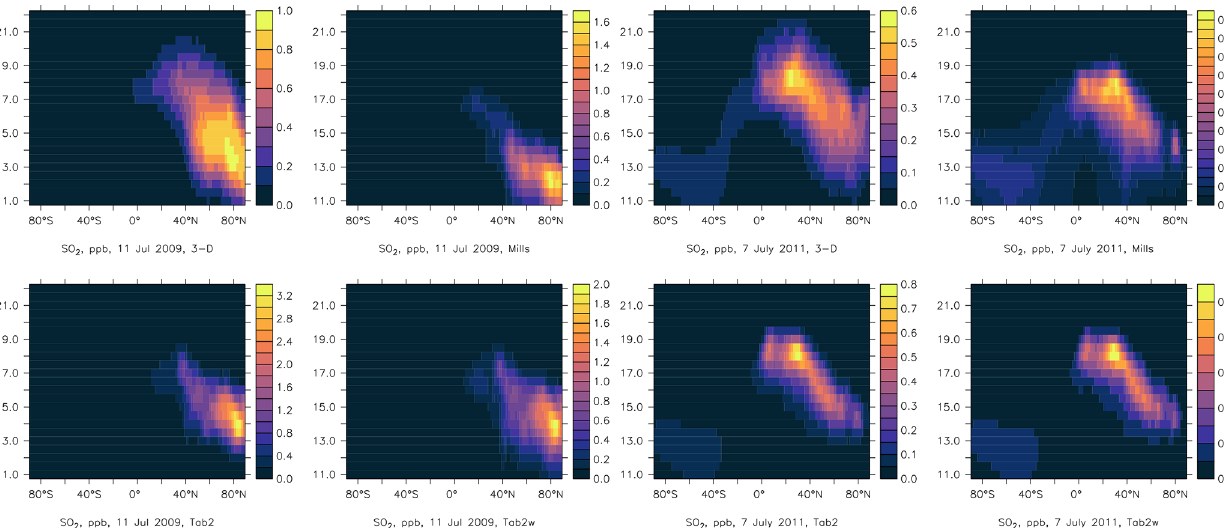
Figure C2. Zonal average SO 2 mixing ratio (ppb) distribution with latitude and altitude (km), 11 July 2009 (four left panels) and 7 July 2011 (four right panels). “3-D” this study, “Mills” emission settings of Mills et al. (2016), “Tab2w” emission in full columns of Table 2, “Tab2” emission starting about 1.2km above the minimum altitude of Table 2.